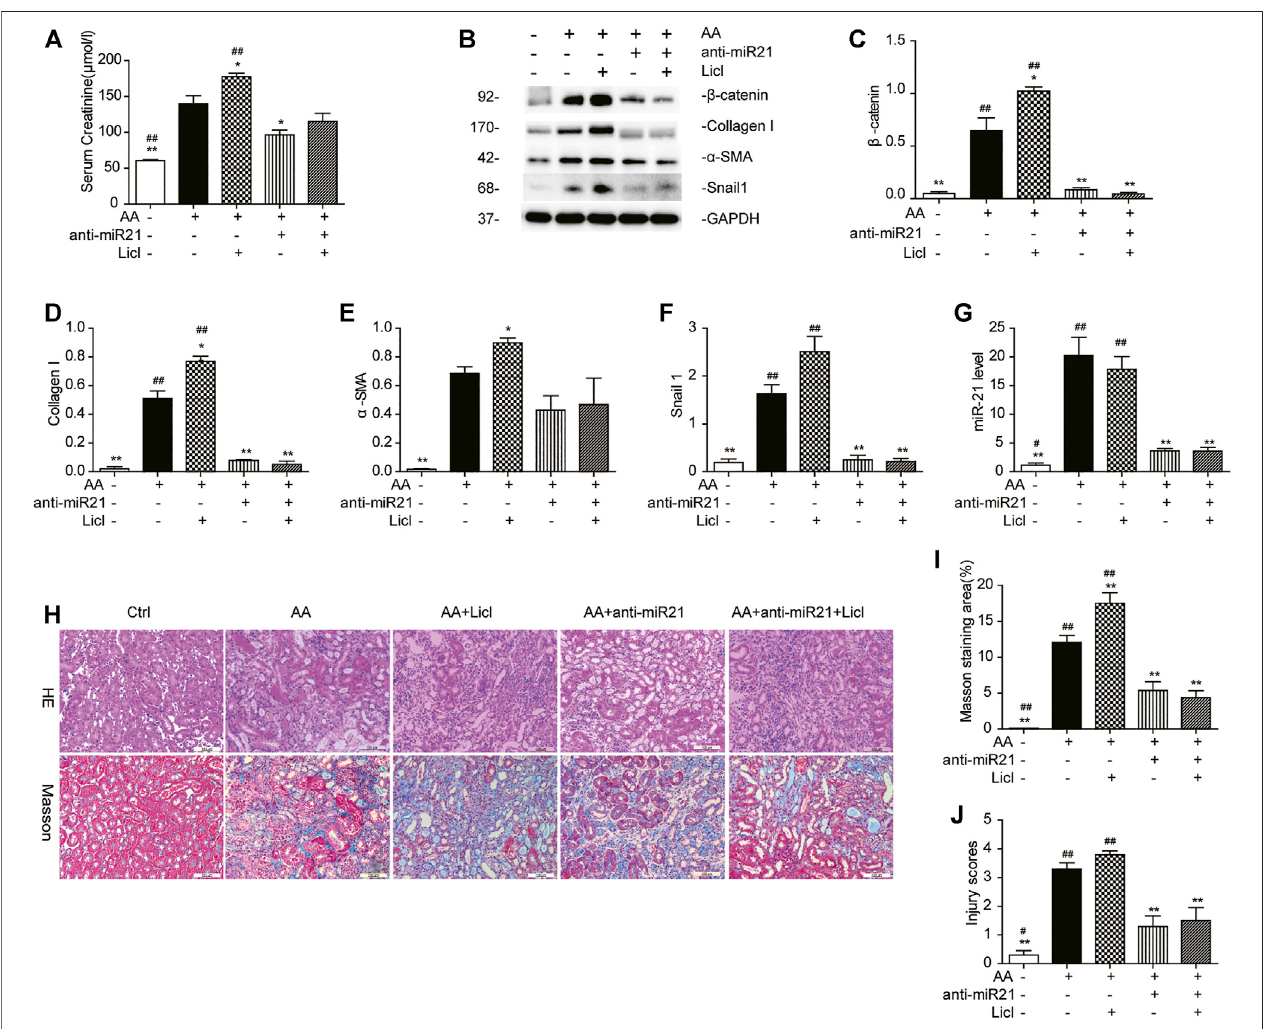
FIGURE7 | LiCldoes not abolishthe anti- fi brotic effectsinducedby anti-miR21 treatment. (A) Serum creatininelevels ofmice with indicated treatmenton days 14 after AA exposure. LiCl (20 mg/kg/d, 10 mg/ml) was administered 24 h post AA treatment, for 7 consecutive days. When LNA-anti-miR21 (10 mg/kg, 5 mg/ml) was applied, the oligos were administered via the tail vein within 60 min prior to AA delivery. (B – F) Western blots and quantitative data of β -catenin, collagen I, α -SMA and snail1 proteins. (G) RT-qPCR results for miR-21 in the kidneys. (H – J) H&E and Masson ’ s trichrome staining and analysis results (magni fi cation, 200 × , bar (cid:2) 200 μ m). * p < 0.05 and ** p < 0.01 vs. AA. # p < 0.05 and ## p < 0.01 vs. AA + Licl + anti-miR21 groups, n (cid:2)